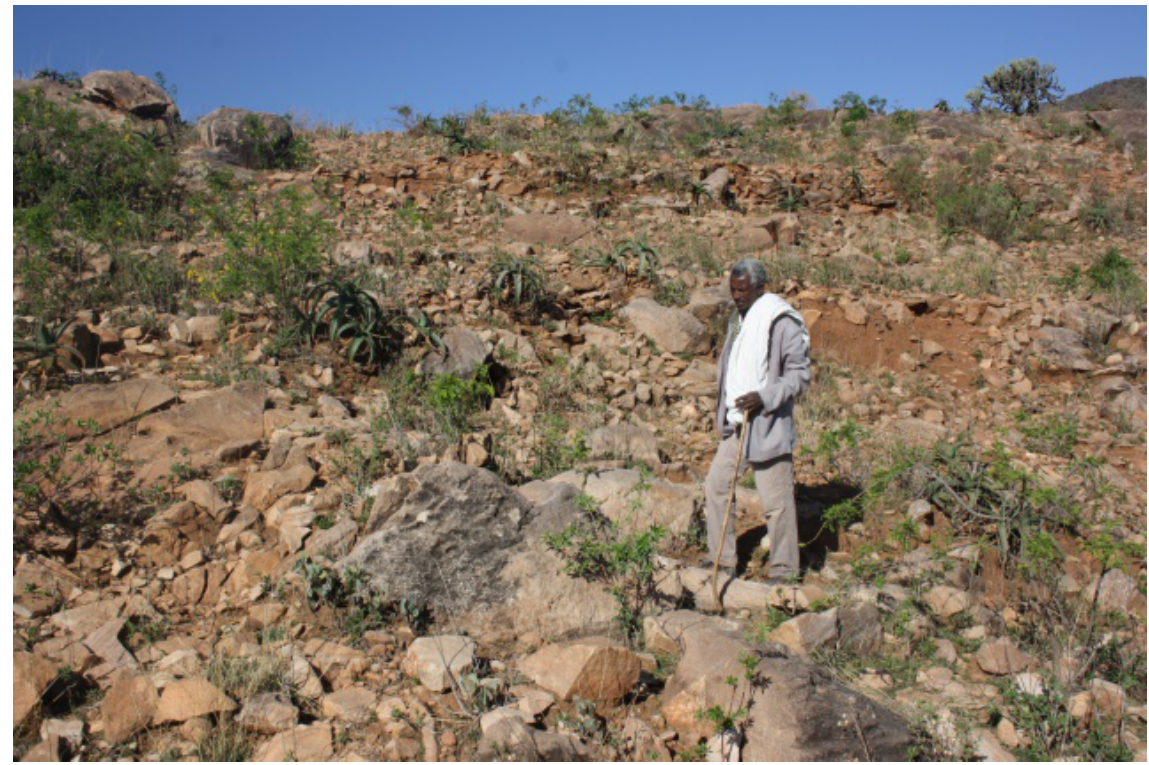
Figure 3. The Gerahu (Grat) Saharti Quarry